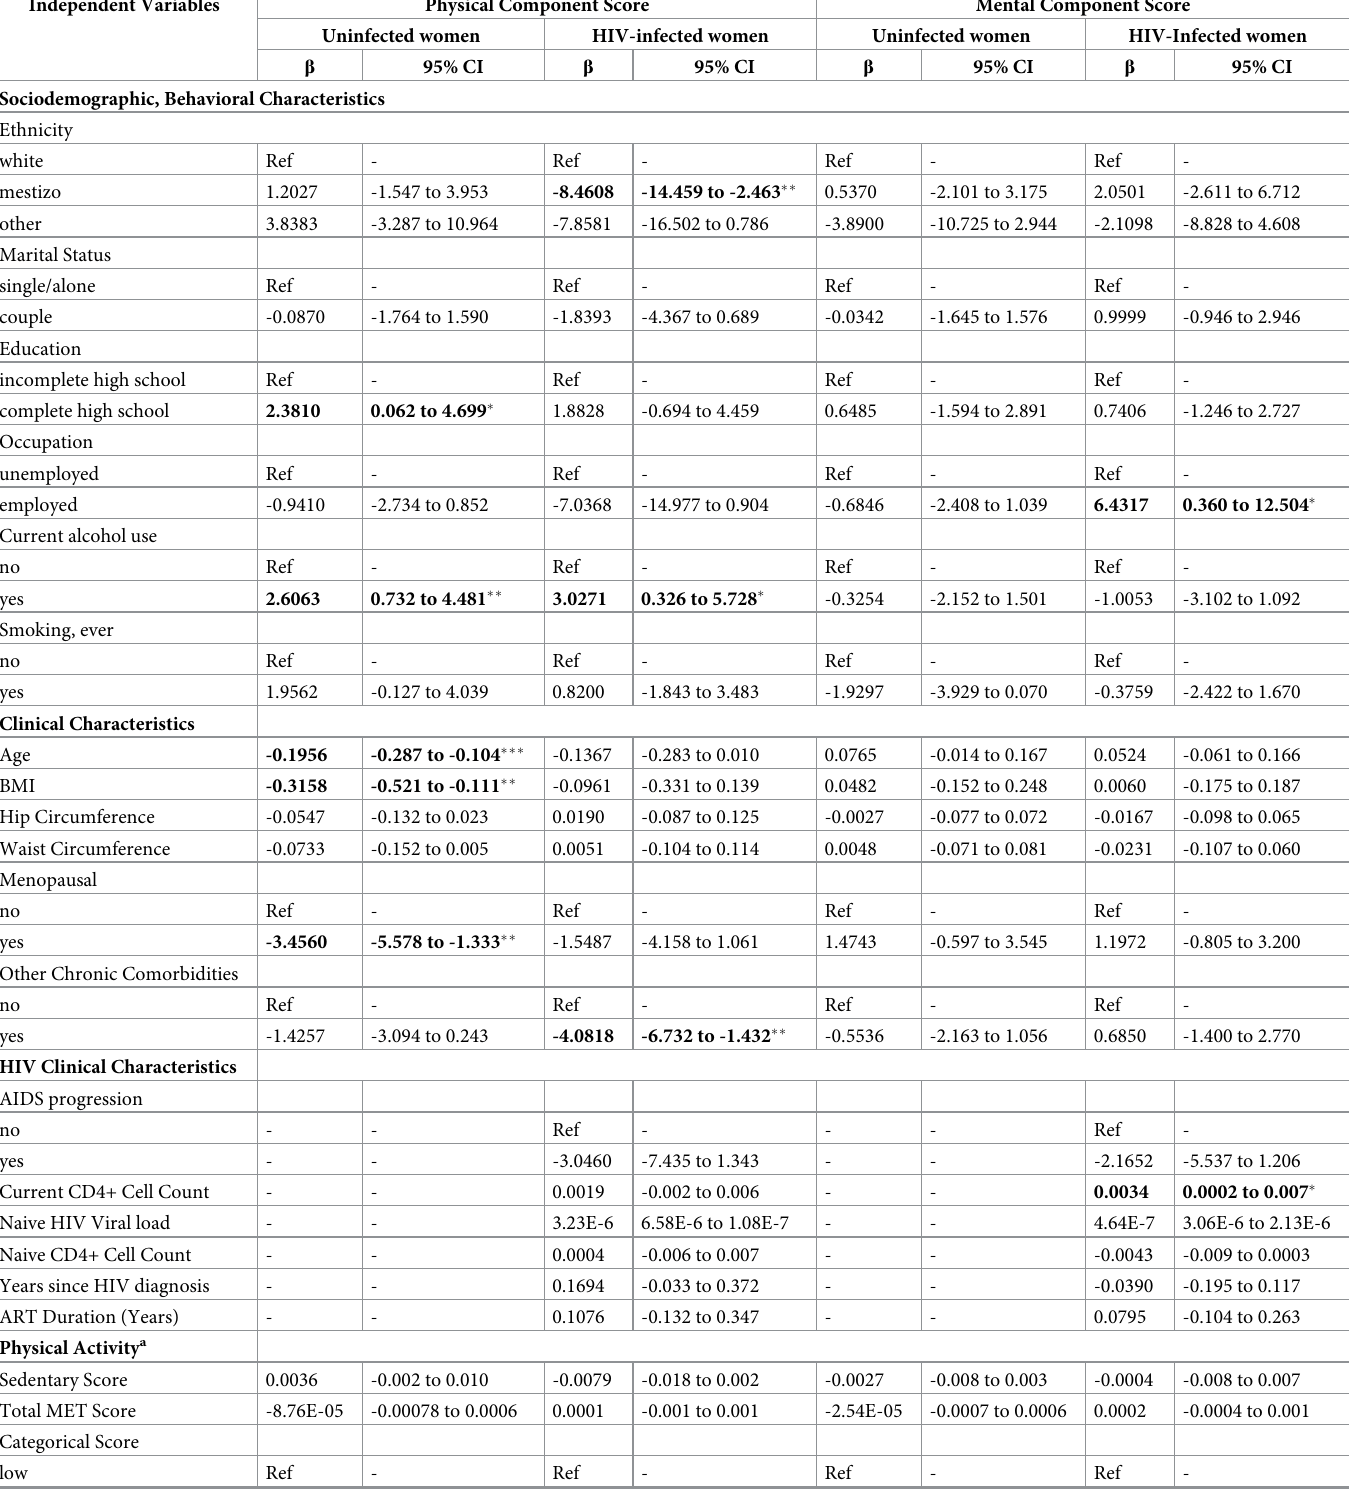
Table 3. Unadjusted regression of factors related to SF-36 component scores. Independent